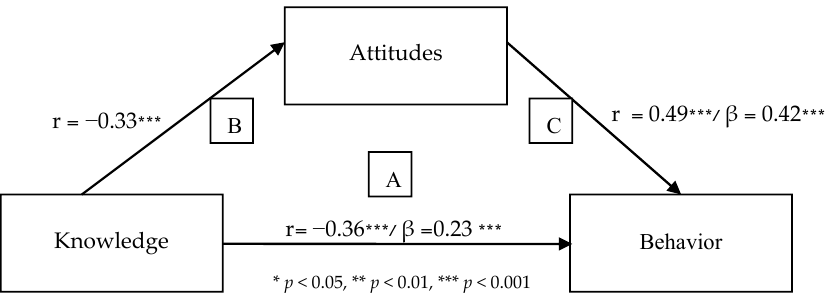
Figure 1. Attitudes mediate the relationship between knowledge and behavior.